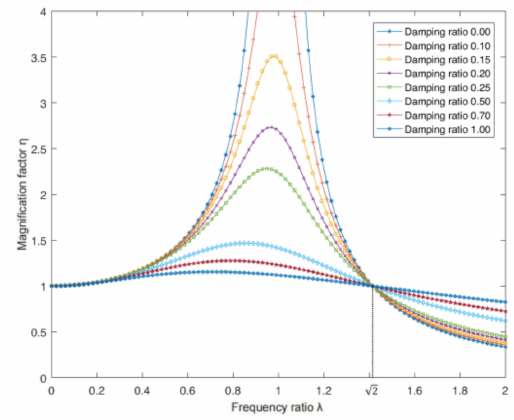
Figure 11. Amplitude-frequency response